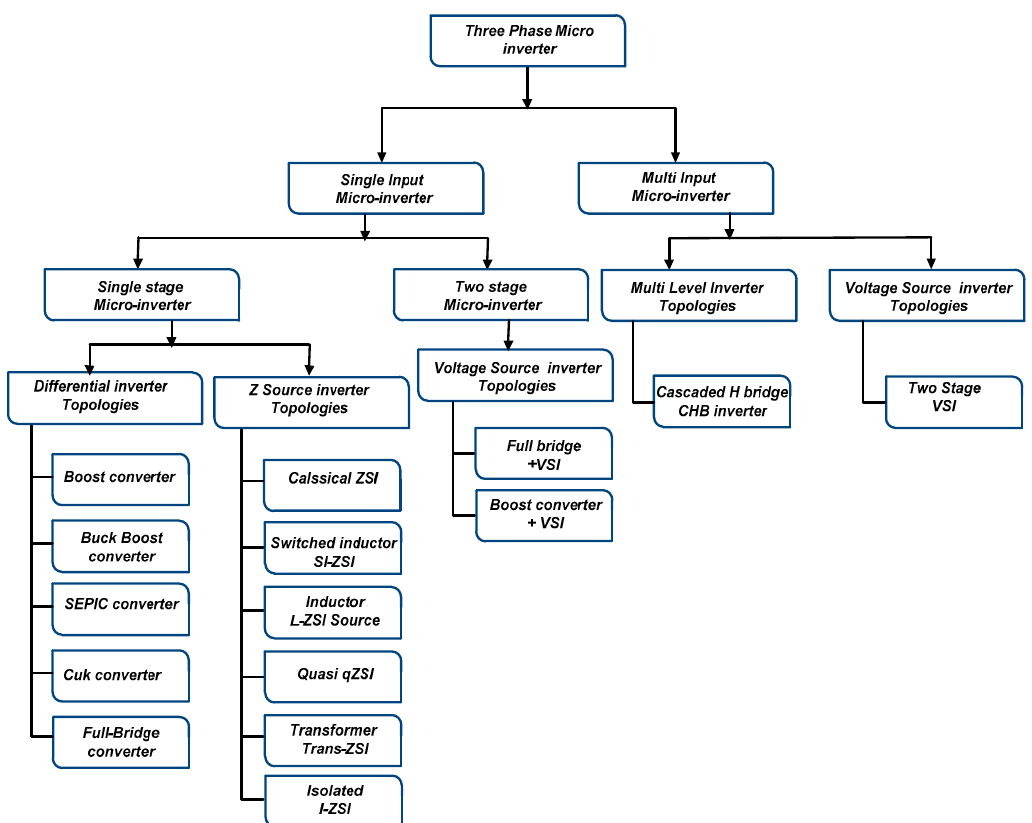
Figure 6. Proposed classification of PV module three-phase microinverter topologies.